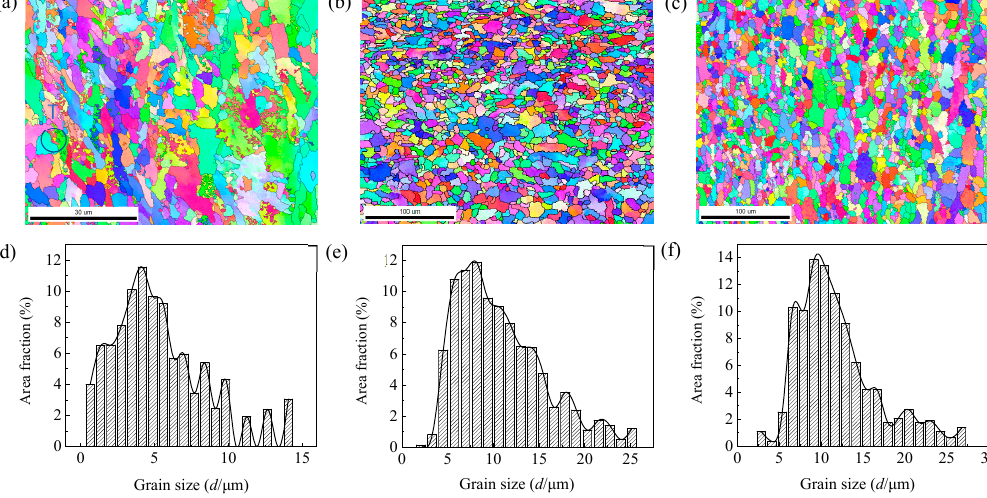
Figure 6. EBSD grain images on 1/4 width sections and grain size distribution of E36 ( a , d ), EH36 ( b , e ), and FH36 ( c , f ).